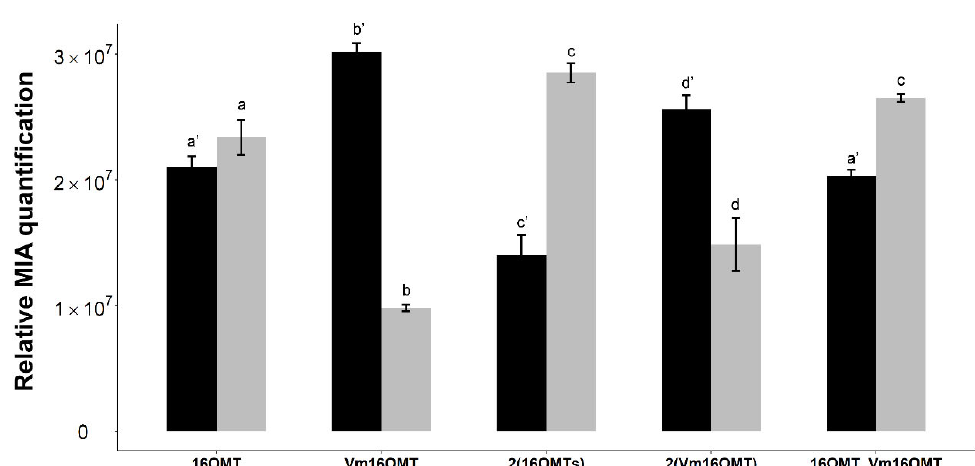
Figure 6. Comparison of 16OMT orthologue activities and effect of gene copy number on tabersonine methoxylation. Yeasts (16OMT strain: episomal expression of 2xT16H2 and 1x16OMT; Vm16OMT strain: episomal expression of 2xT16H2 and 1xVm16OMT; 2(16OMTs): episomal expression of 2xT16H2 and 2x16OMT; 2(Vm16OMT) strain: episomal expression of 2xT16H2 and 2xVm16OMT; 16OMT_Vm16OMT strain: episomal expression of 2xT16H2, 1x16OMT and 1xVm16OMT) were fed with tabersonine (250 µ M) before analysis of the MIA content in the culture medium by UPLC-MS. Statistical analyses were performed with ANOVA followed by a Tukey test. Same letters express no significant difference between the means of the same MIA at 5% of significance: a’ , b’ , c’ , d’ = 16-hydroxytabersonine and a , b , c , d = 16-methoxytabersonine. Black = 16-hydroxytabersonine, grey = 16-methoxytabersonine. Error bars correspond to the standard error of biological replicates ( n = 3). MIA composition of the yeast culture medium is expressed as relative peak